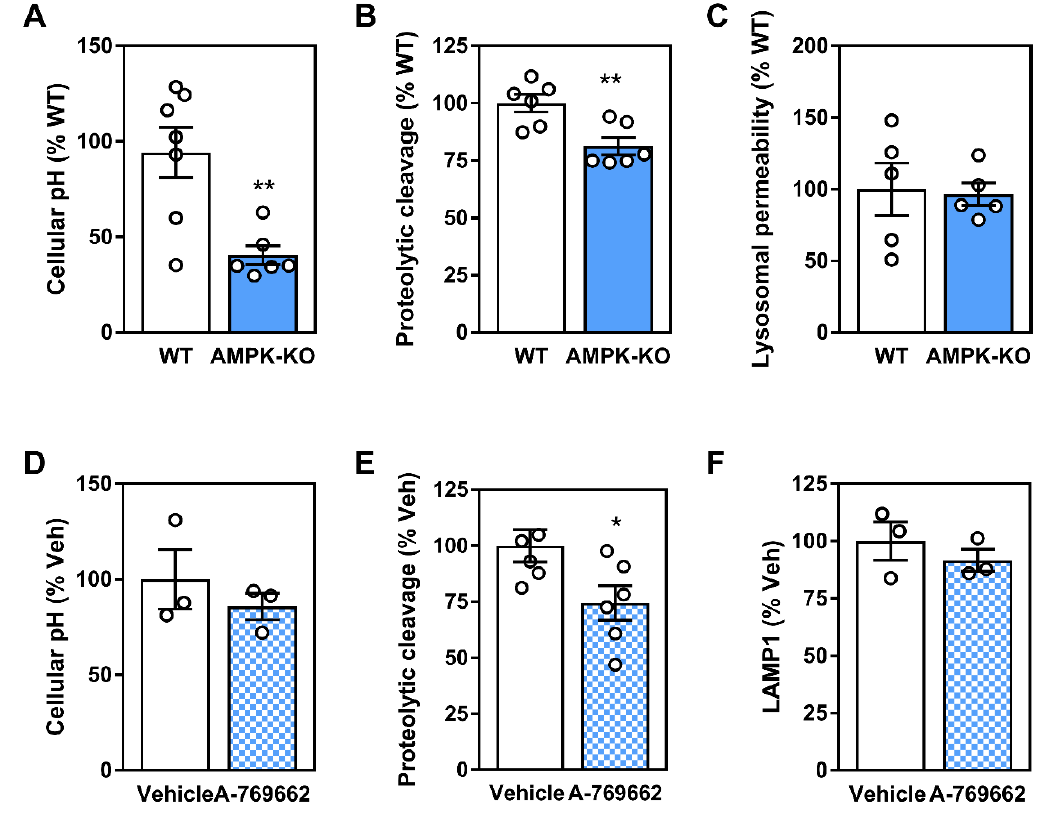
Figure 8. Macrophage AMPK expression and activation influence parameters for lysosomal homeostasis. WT and AMPKβ1-deficient macrophages were assessed for ( A ) cellular acidity, ( B ) DQ-ovalbumin proteolytic cleavage, and ( C ) lysosomal membrane permeability. WT and AMPKβ1- deficient macrophages were treated ± A-769662 (100 µM) for 24 h followed by measurement of ( D ) cellular acidity, ( E ) DQ-ovalbumin proteolytic cleavage, and ( F ) LAMP1 staining. Data represent the mean ± SEM, where * and ** represent p < 0.05 and p < 0.01 as calculated by the two-tailed Student’s t -test.